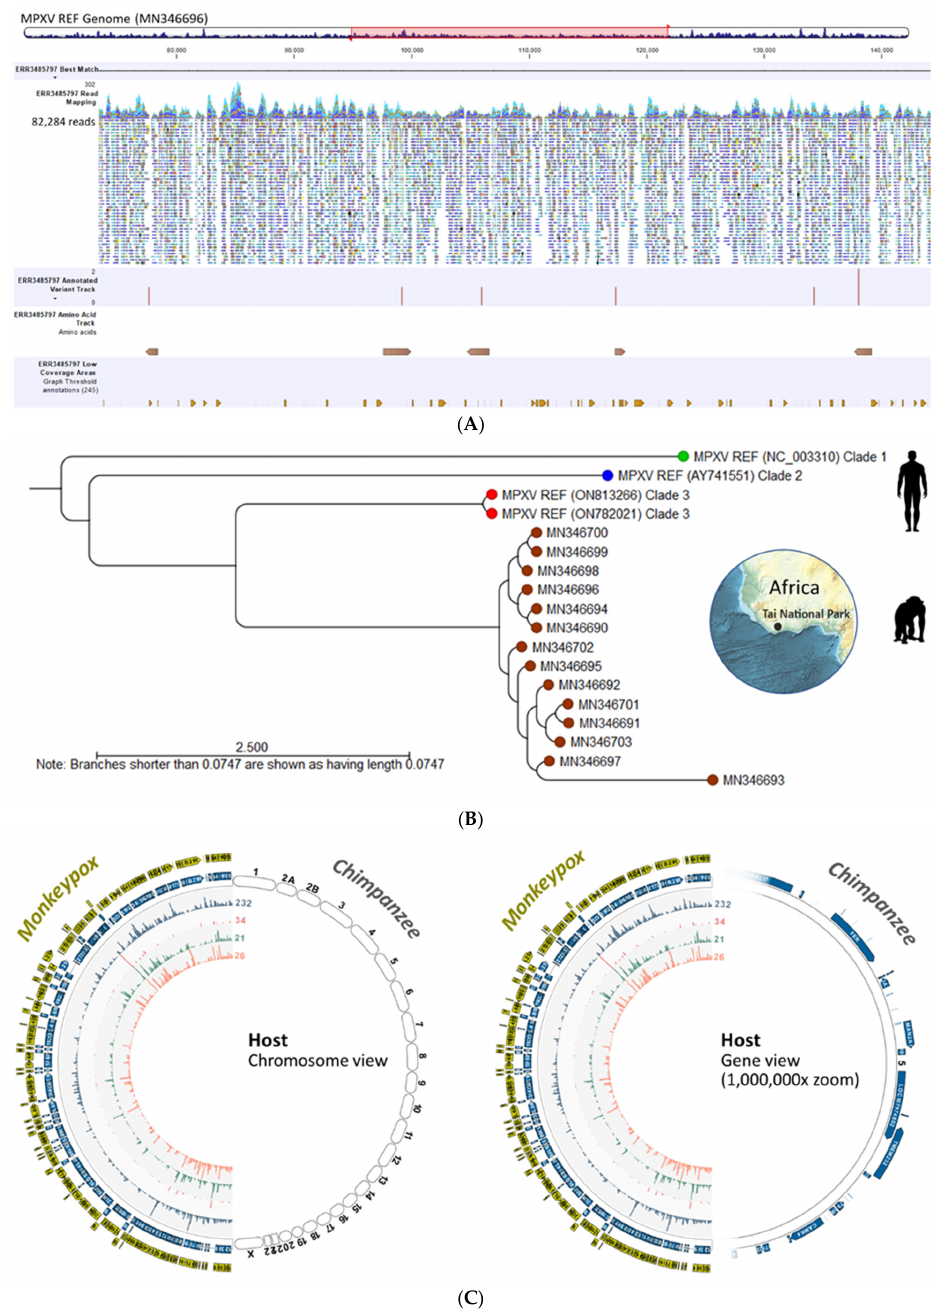
Figure 6. Utility of the MPXV database for sequence and phylogenetic analysis using a Chimpanzee dataset. ( A ) A deep-sequenced MPXV sample (ERR3485797) extracted from Chimpanzee feces is analyzed with the Viral Hybrid Capture (VHC) automated workflow. The resultant VHC track list displays (top to bottom): read mapping against the closest MPVX reference genome, annotated variant track, MPXV amino acid track, and low coverage areas; ( B ) Phylogenetic analysis of the consensus sequences derived from the Chimpanzee dataset ( n = 14) reveals significant divergence from the human MPXV. Among the Chimpanzee MPXV sequences, two clades are revealed; ( C ) Viral- host Integration Site (VIS) analysis for sample (ERR3485797) visualized as circular plots. The bipartite MPXV/Chimpanzee genomes in chromosome view (left) and gene view (1,000,000 × zoom, right) did not reveal any sites of viral integration. (Virus–host integration linkages are designated by bi-directional curvilinear lines between the virus and host